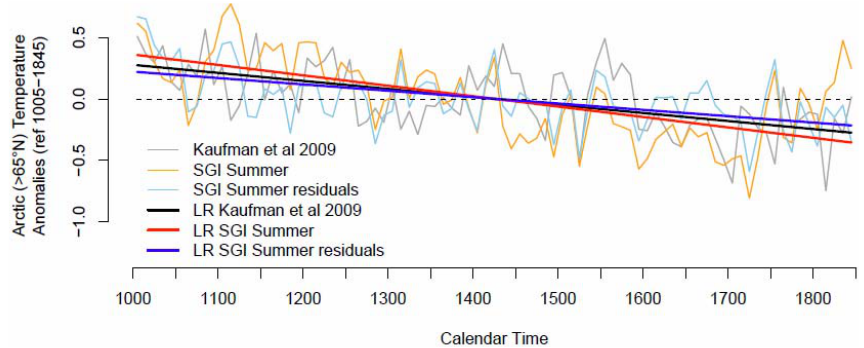
Fig. 8. Comparison between the Arctic summer temperature reconstruction provided by (Kaufman et al., 2009) (grey and black lines) and SGI. The orange and red lines show the summer mean in SGI. The blue lines show the residuals calculated as the summer temperature time series in SGI, minus the signatures of TSI and CO 2 (equivalent to the ε 3 residuals in Eq. 3). The grey, orange and light blue thin lines represent the ten-year smoothed time series of (Kaufman et al., 2009), SGI summer mean and SGI summer residuals, respectively. The thick black, red and blue lines show the linear regressions associated with the summer temperature time series of (Kaufman et al., 2009), SGI summer mean and SGI summer residuals respectively.